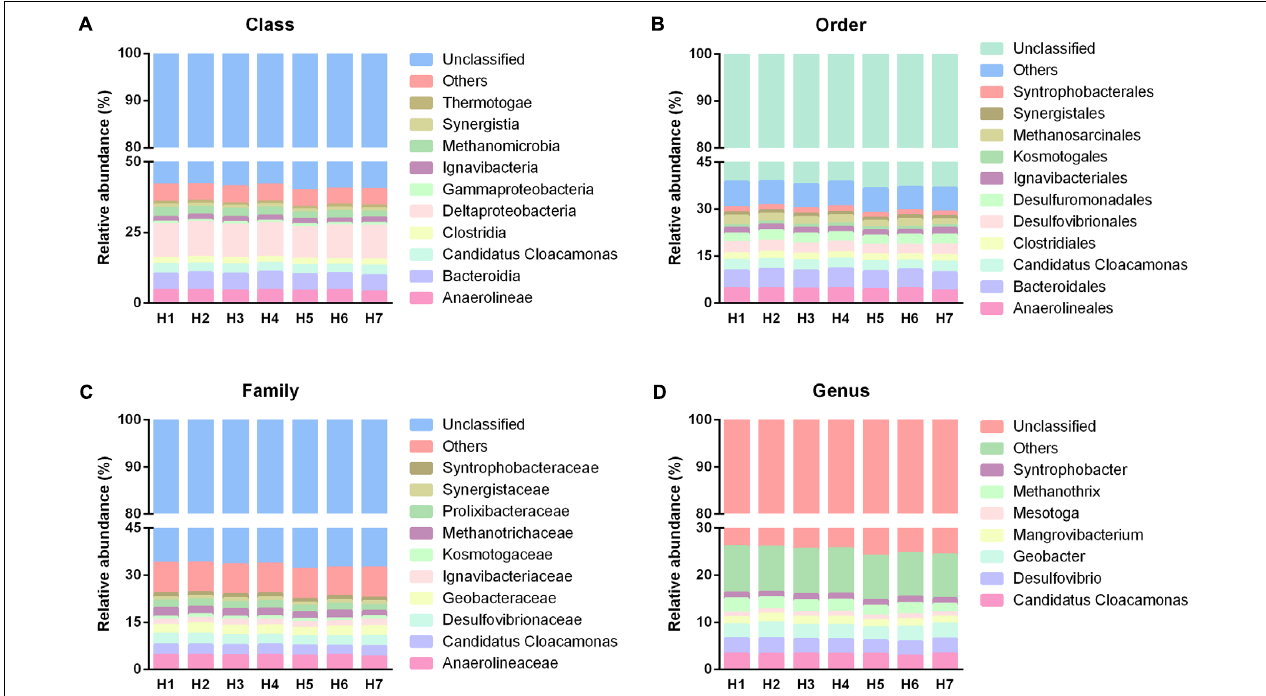
FIGURE 8 | Taxonomic distribution of different sampling heights from class to genus. (A–D) Were the taxonomic information of predominant populations in class, order, family and genus level,